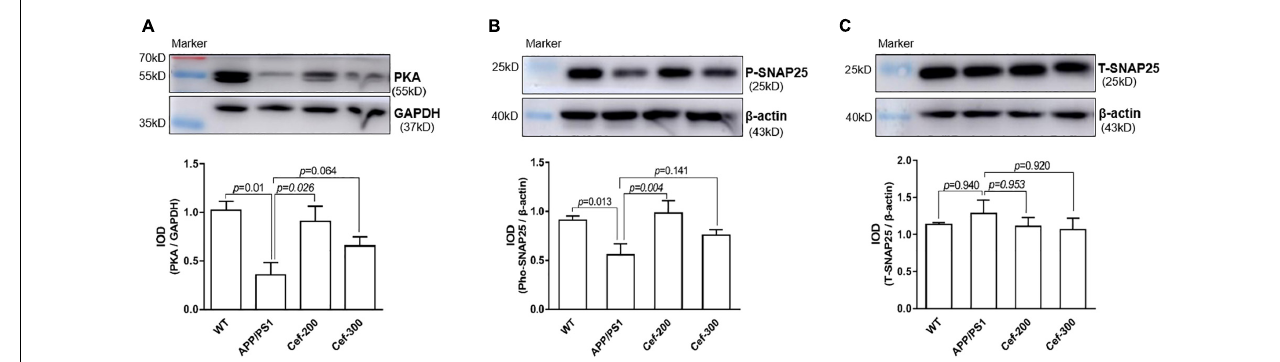
FIGURE 4 | Cef upregulates the expression of PKA and phosphorylated SNAP-25 in the hippocampus of APP/PS1 mice. The upper in each of (A–C) is a representative immunoblot of Western blot and analysis, and the lower is the quantitative presentation of the immunoblot with IOD. The number of mice for each test is shown in Table 1 . PKA, protein kinase A; P-SNAP25, phosphorylated synaptosomal-associated protein 25 kDa; T-SNAP25, total synaptosomal-associated protein 25 kDa. The italic values upon the bars are statistical P values.